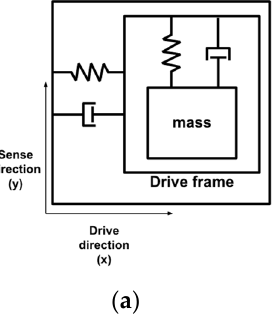
Figure 7. Evolution of the MEMS accelerometer through the 6 generations optimization of the GA. After 6 generations, the suspension beam width is reduced and the proof mass is enlarged.